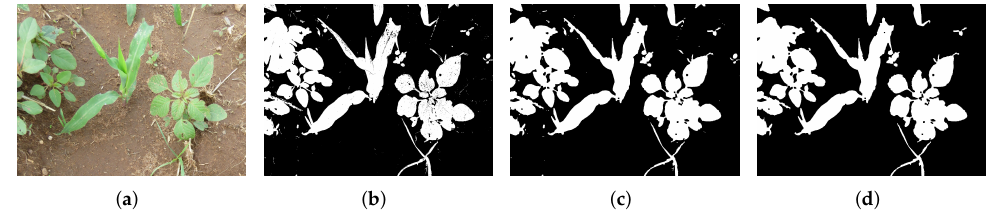
Figure 4. Segmentation stages of images. ( a ) original RGB. ( b ) thresholding output. ( c ) improved image. ( d ) final output